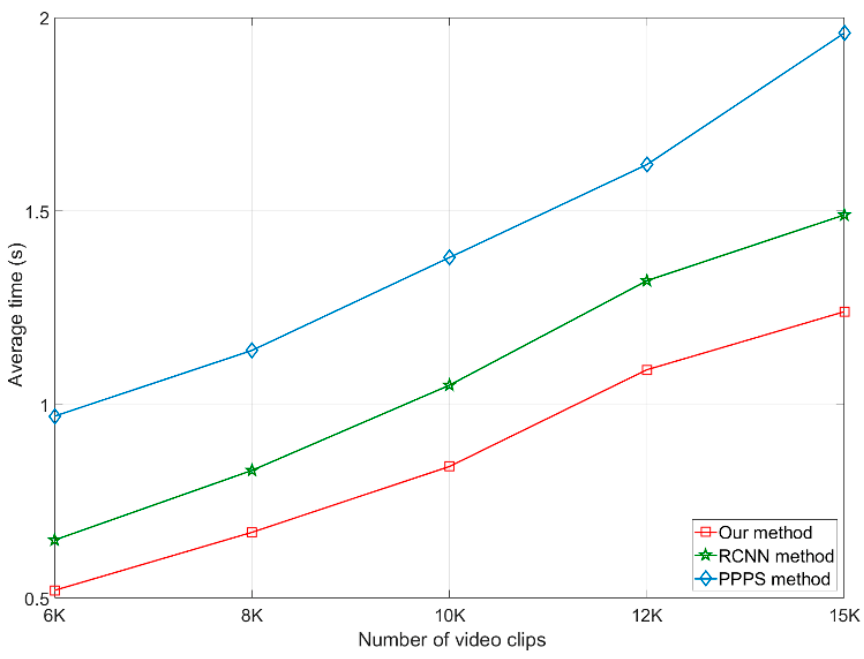
Figure 8. The accuracy comparison between our method and the PPPS method with different num- bers of video clips: ( a ) MAP comparison; ( b ) Top-1 accuracy comparison. numbers of video clips: ( a ) MAP comparison; ( b ) Top-1 accuracy comparison.